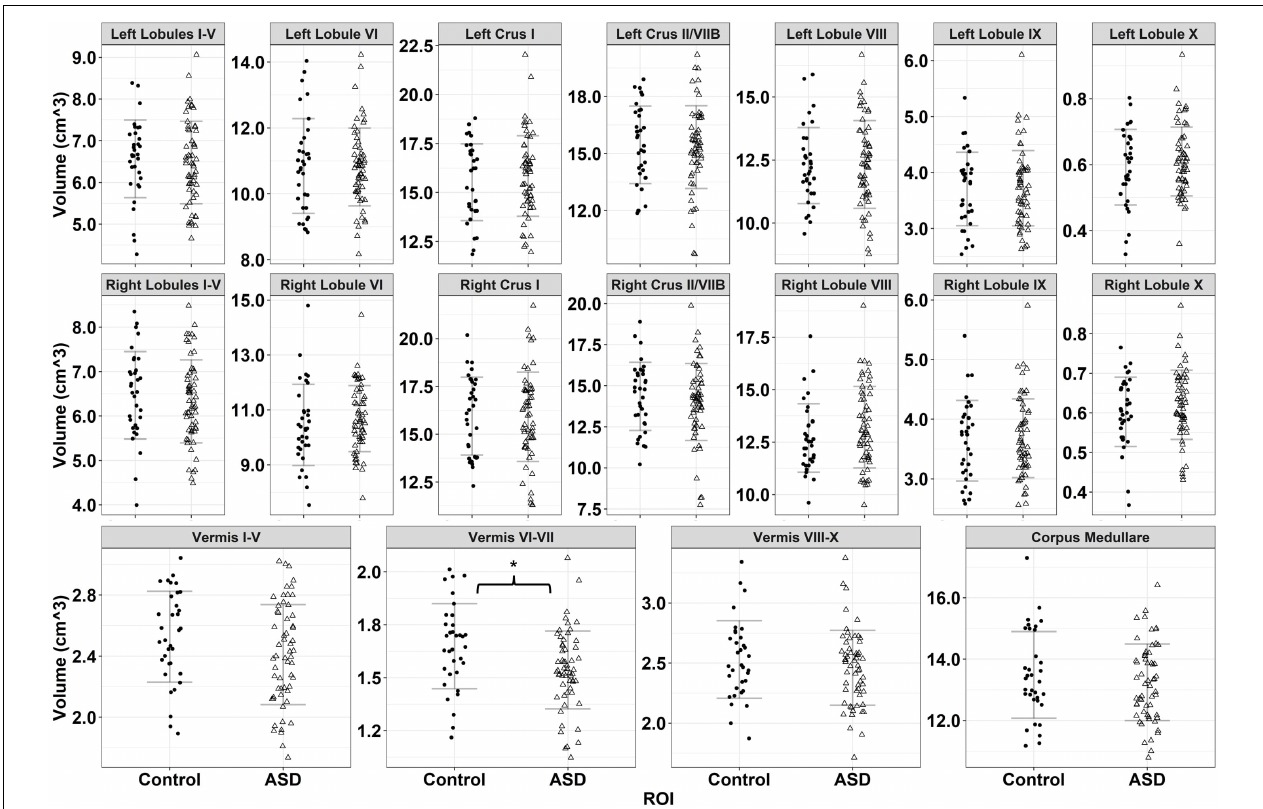
FIGURE 4 | Volumes for 18 cerebellar ROIs for typically developing controls (black circles) and individuals with ASD (empty triangles). Error bars reflect mean ± 1 SD. * denotes p < 0.05.